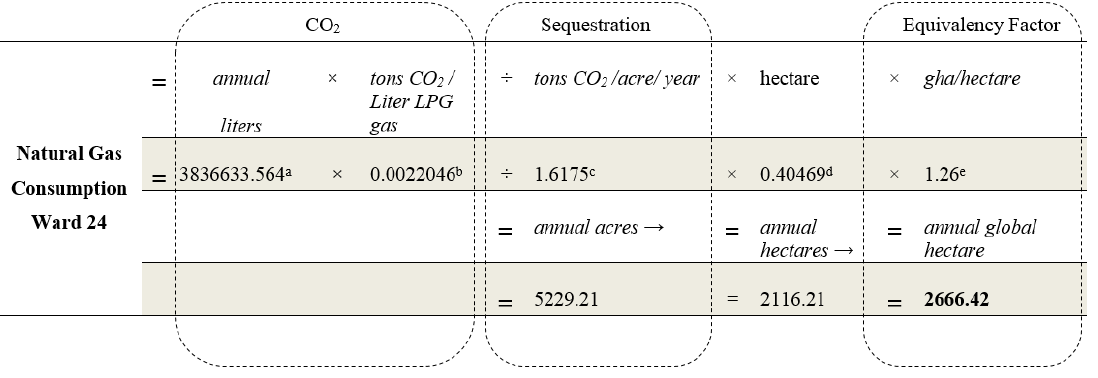
Figure 6. Natural gas consumption footprint calculation and derivation. Source: a Household Survey of Ward 24 Residential Area (2015), [54], b [55], c [56]; d [57]; e [46].